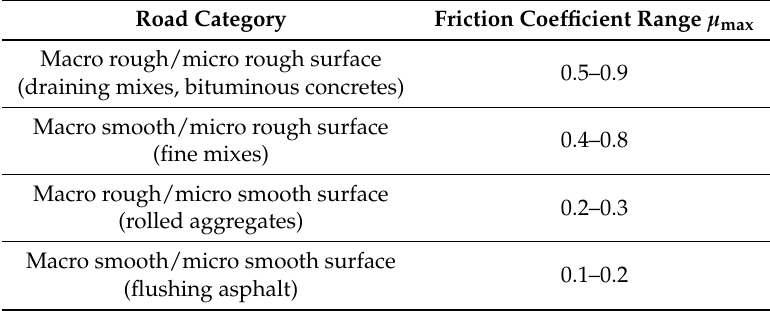
Table 1. Friction coefficient for four different broad categories of wet road surfaces [2].